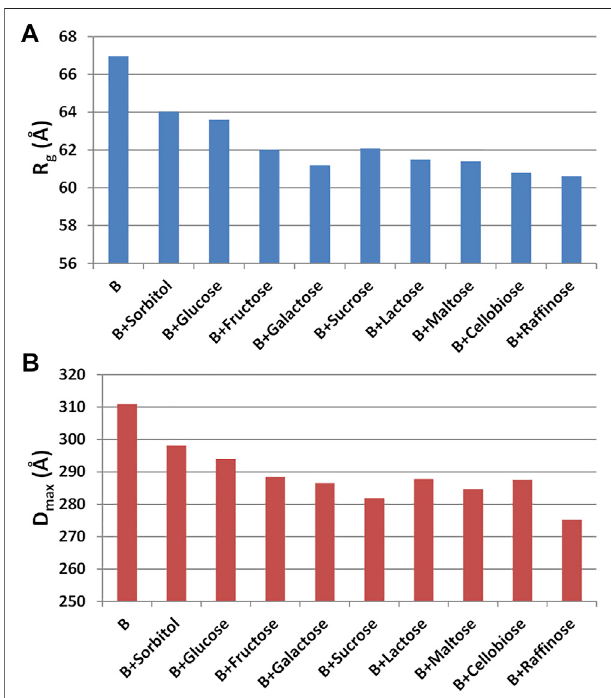
FIGURE 14 | (A) Radius of gyration ( R g ) and (B) maximum inter-particle distance ( D max ) measured for rituximab in buffer B at 8 mg/mland in presence of mono-, di- and tri-saccharides.